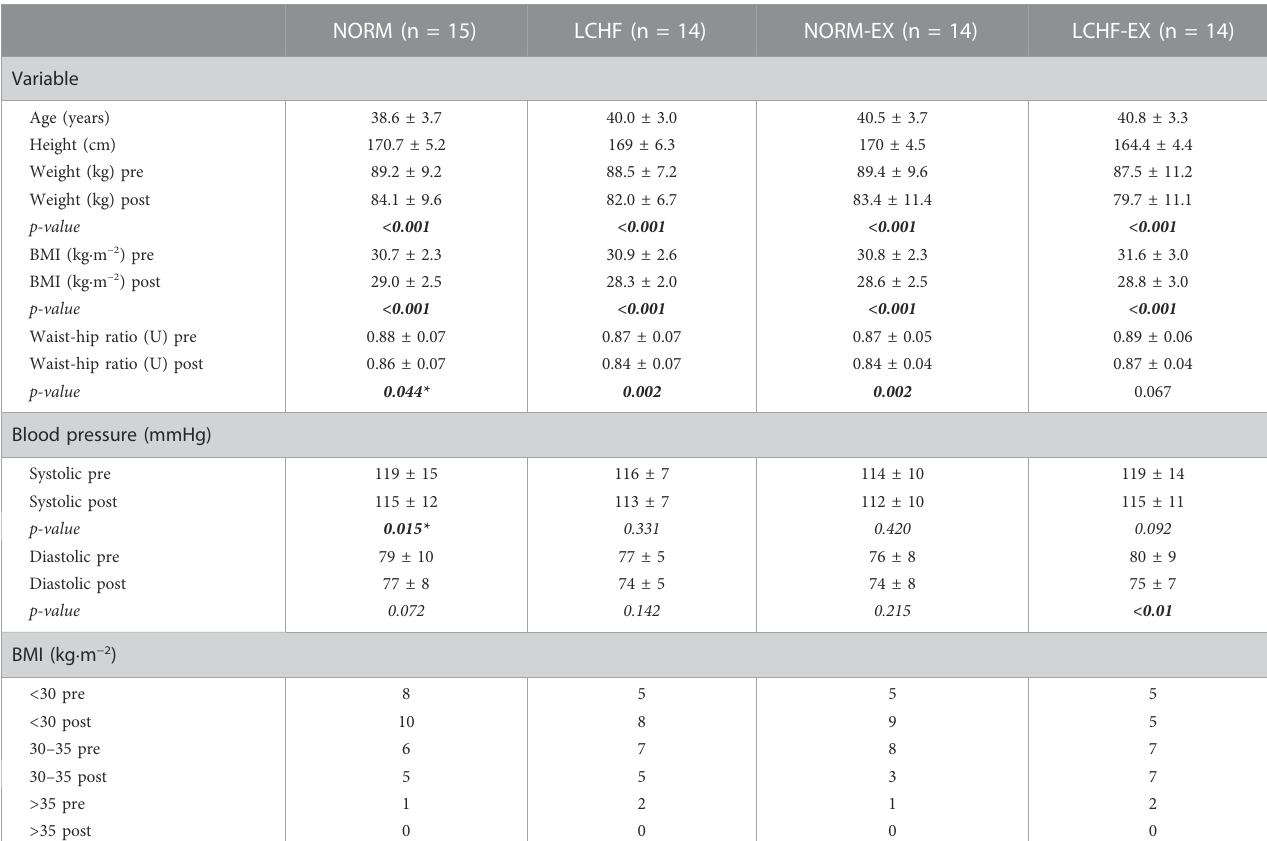
TABLE 1 Baseline